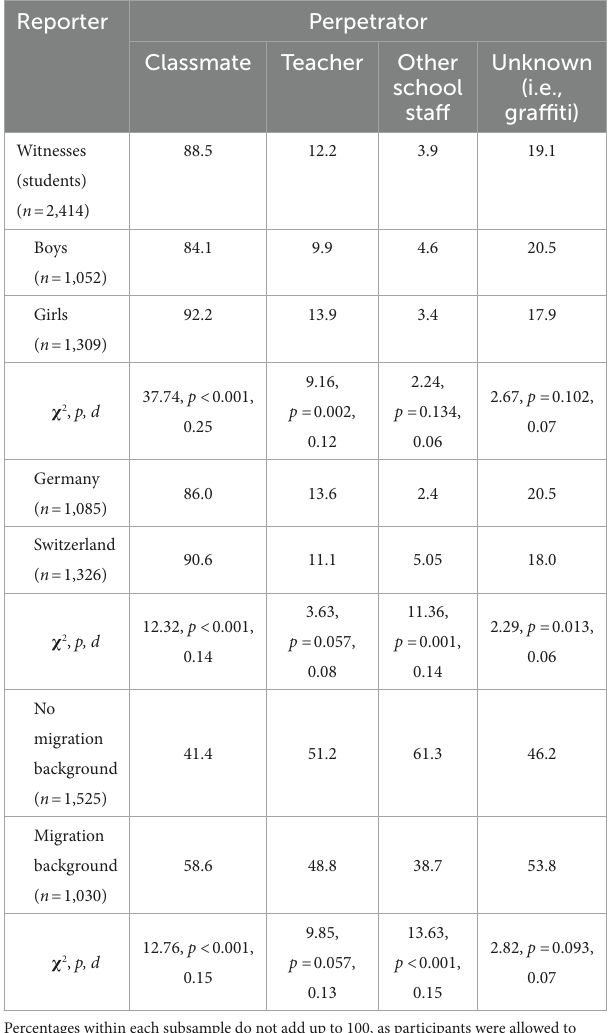
TABLE 3 Perpetrators of offline hate speech, by country, gender, and migration status of the witnesses.